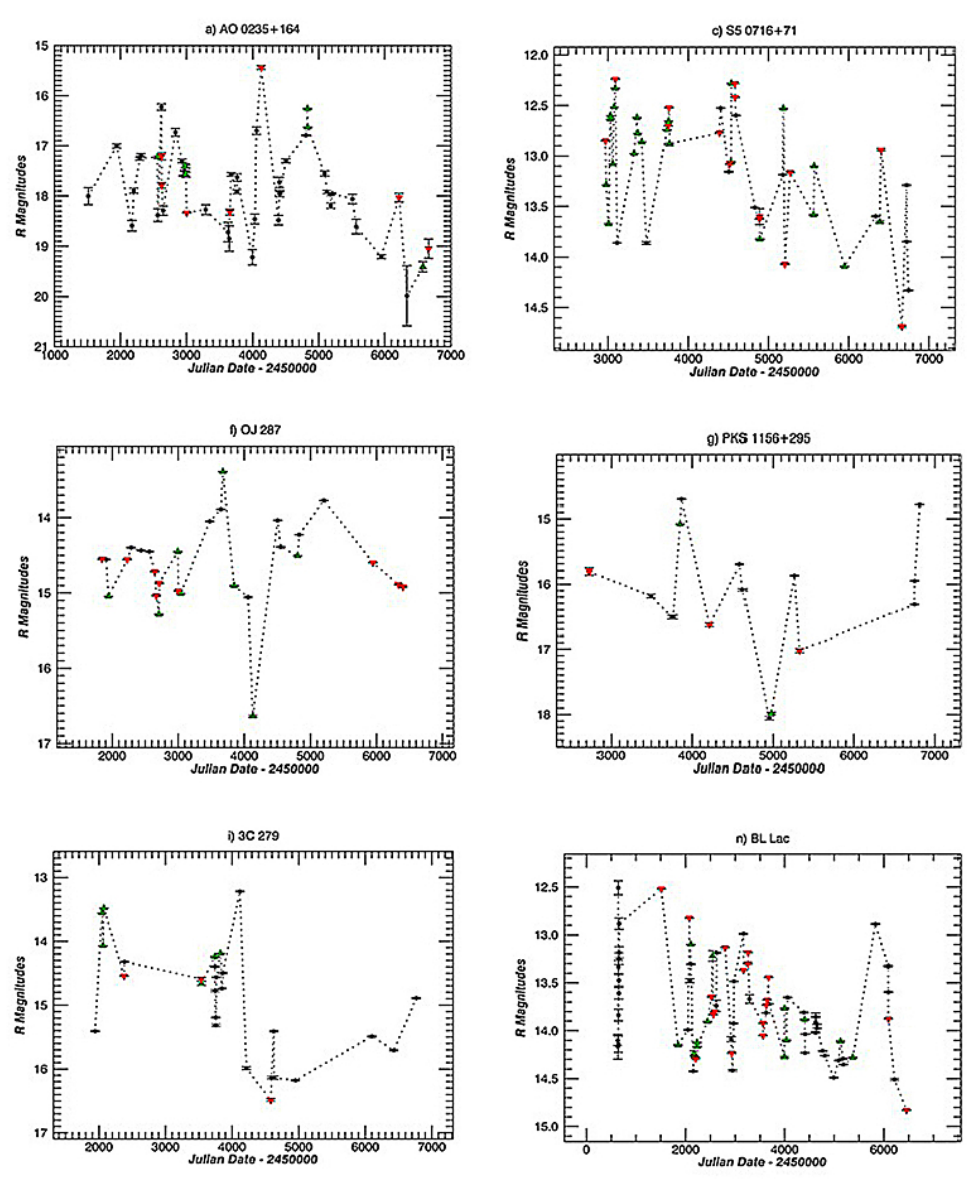
Figure 3. Long-term light curves of six of the sources from Table 1. The objects are in clockwise order: AO 0235+164, S5 0716+71, PKS 1156+295, BL Lac, 3C 279, and OJ 287. Green up-pointing arrows indicate that micro-variability was seen during that observation. The red down-pointing arrows indicated that no micro-variability was seen during the night. Note that for these six objects in particular, the green and red arrows both encompass the entire range of brightness and do not appear to be correlated with brightness